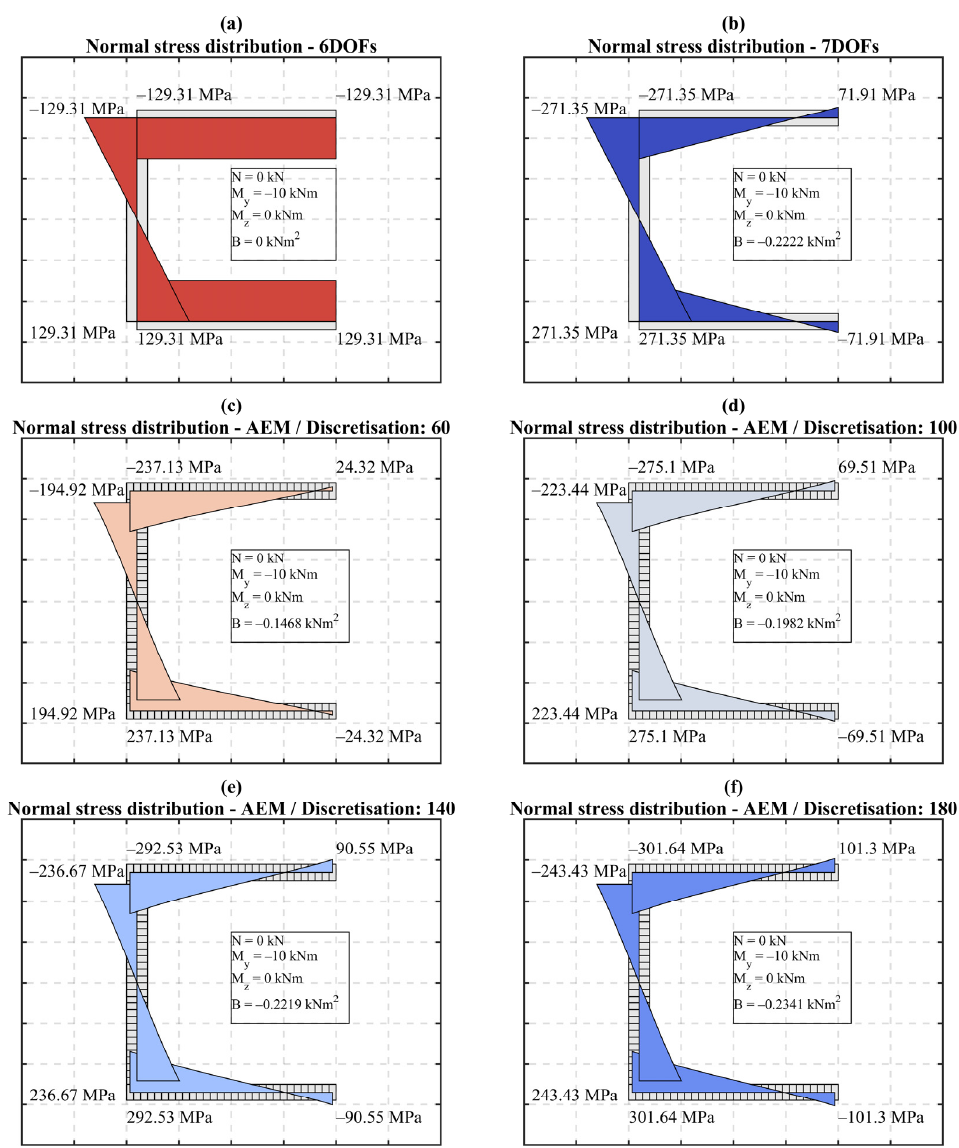
Figure 9. Normal stress distribution for Section #3, with a length L = 1000 mm and a section discretisation of 30 blocks for each section part.